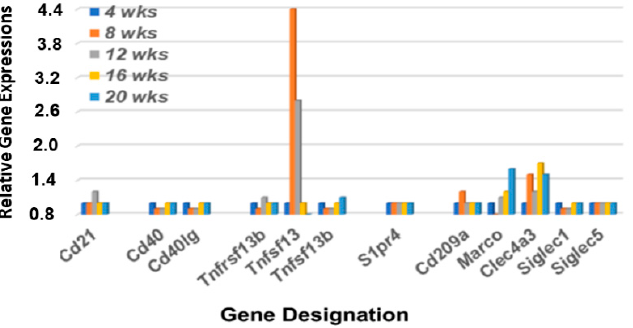
Figure 4. Differential expression profiles for genes encoding various receptors associated with MZB cell functions. Transcriptome data showing the temporal expression of MZB cell-associated receptor genes ( Cd21 , Cd40 , S1pr4 , and Tnfrsf13b ), receptor ligands ( Cd40lg , Tnfsf13 , and Tnfsf13b ) and macrophage receptors ( Cd209b , Marco , Clec4a3 and Siglec1 ) in lacrimal glands of C57BL/6.NOD- Aec1Aec2 mice.